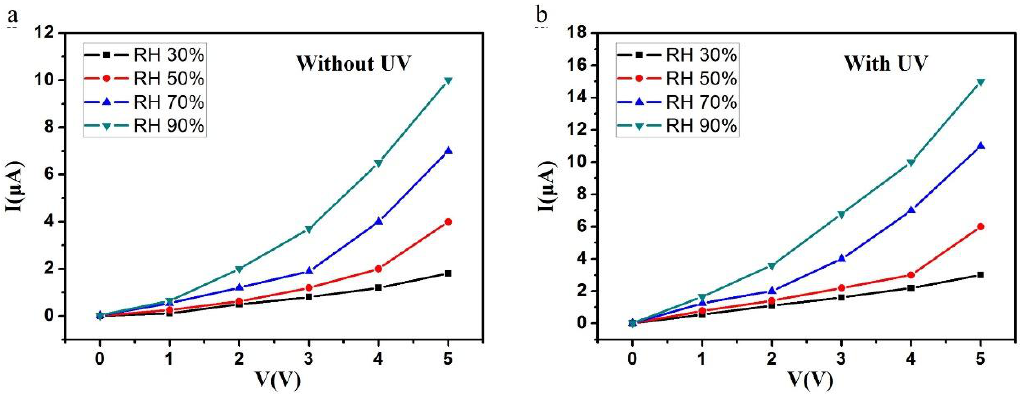
Figure 8. I-V curves measured from 30% RH to 90% RH. ( a ) Without UV irradiation; ( b ) With UV irradiation.